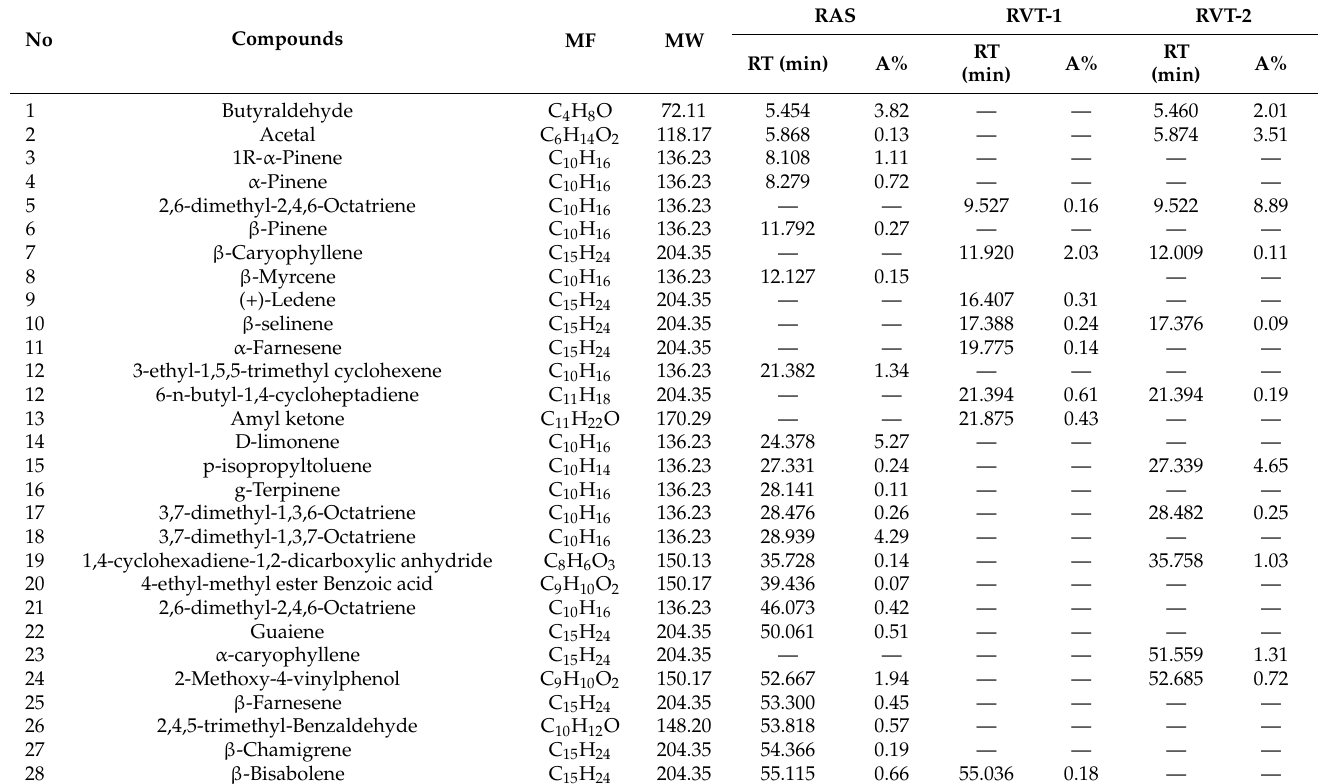
Table 3. Volatility chemical composition of RVT and